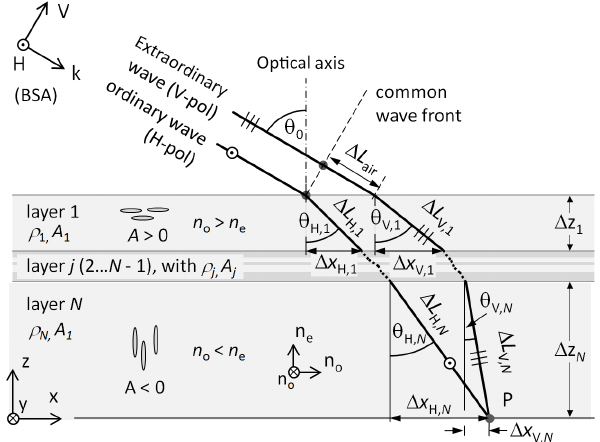
Figure 2. An electromagnetic wave (H- or V-polarized) is trans- mitted in k direction with respect to the radar coordinate system ( H , k , V ) and with an incidence angle θ 0 with respect to the snow surface. The electric field of the H-polarized wave is perpendicu- lar to the optical axis ( z ) and sees the ordinary refractive index n o (therefore called the “ordinary wave”). The electric field of the V- polarized wave has a component parallel to the optical axis and is affected by the extraordinary refractive index n e (the “extraordinary wave”). For horizontally aligned structures ( A> 0) the extraordi- nary wave travels faster ( n e <n o ) whereas for vertical structures the ordinary wave is faster ( n o <n e ). As refraction differs for both waves, the optical distances also differ when measured from a com- mon wave front to the same point P on the ground. Describing the radar reflection at a common point P seems arbitrarily chosen, but only reflections from common scatterers within one radar resolu- tion cell contribute to the CPD as described in Sect. 3.2. The struc- tural anisotropy of the layers is shown as expected for fresh snow (layer 1) deposited on top of old snow (layer N ). The layer of fresh snow with density ρ 1 and thickness (cid:49)z 1 is drawn with horizontal structures with a anisotropy A> 0. The thick layer of old snow is drawn as vertical ice grains ( A< 0) grown by temperature gradi- ent metamorphism. The theory in this paper is true for any random layering of densities and anisotropies due to Snell’s law as long as absorption and volume scattering are